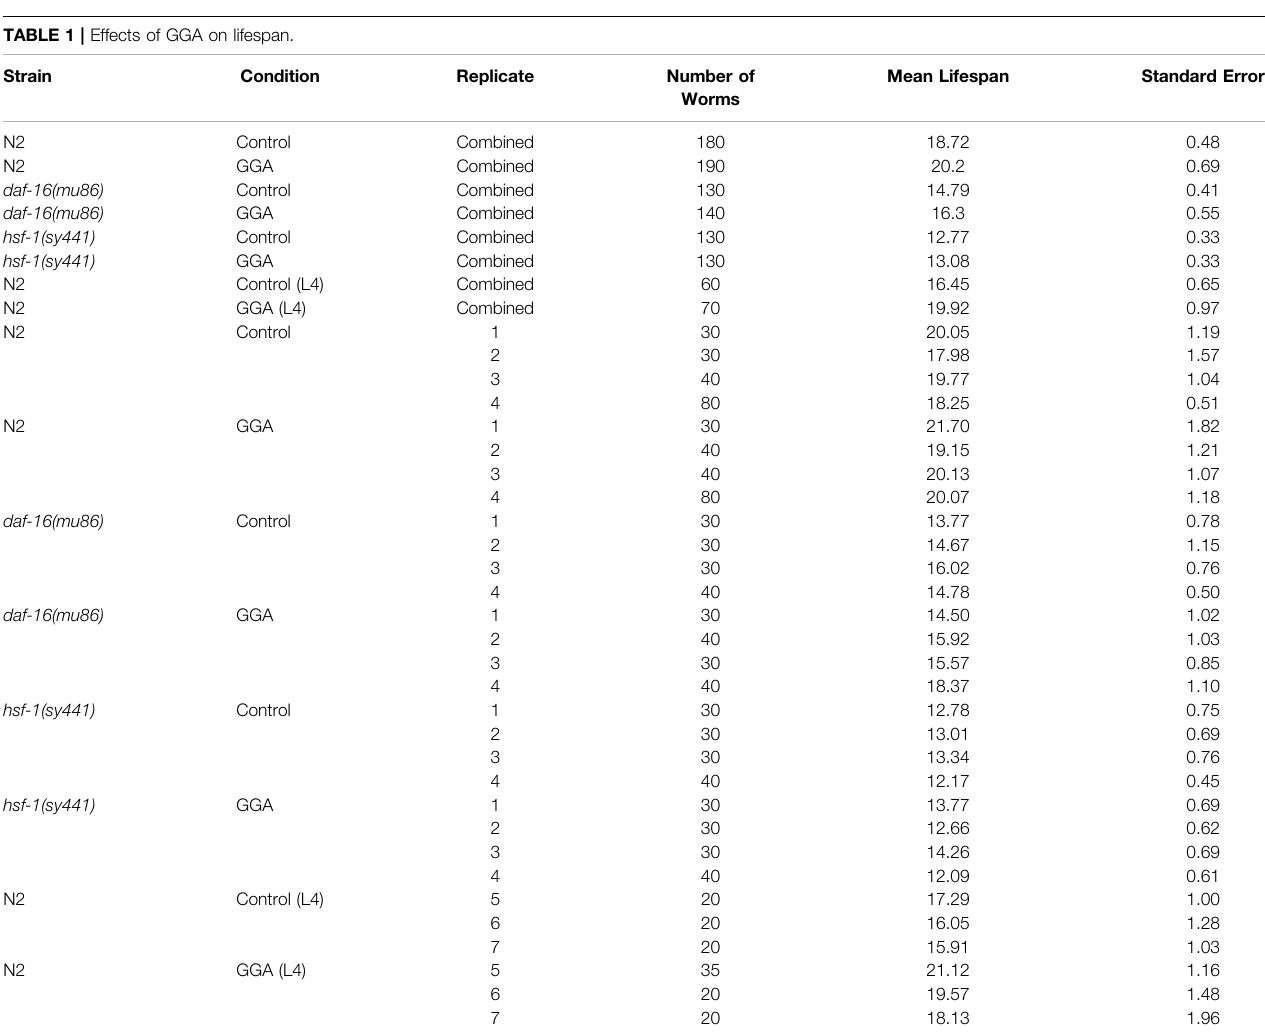
TABLE 1 | Effects of GGA on